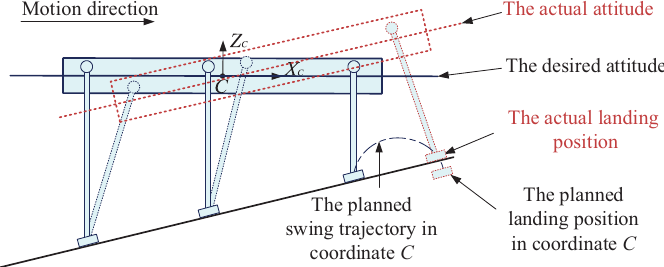
Figure 6. The diagram of the attitude adjustment obstruction caused by the traditional swing trajectory design.